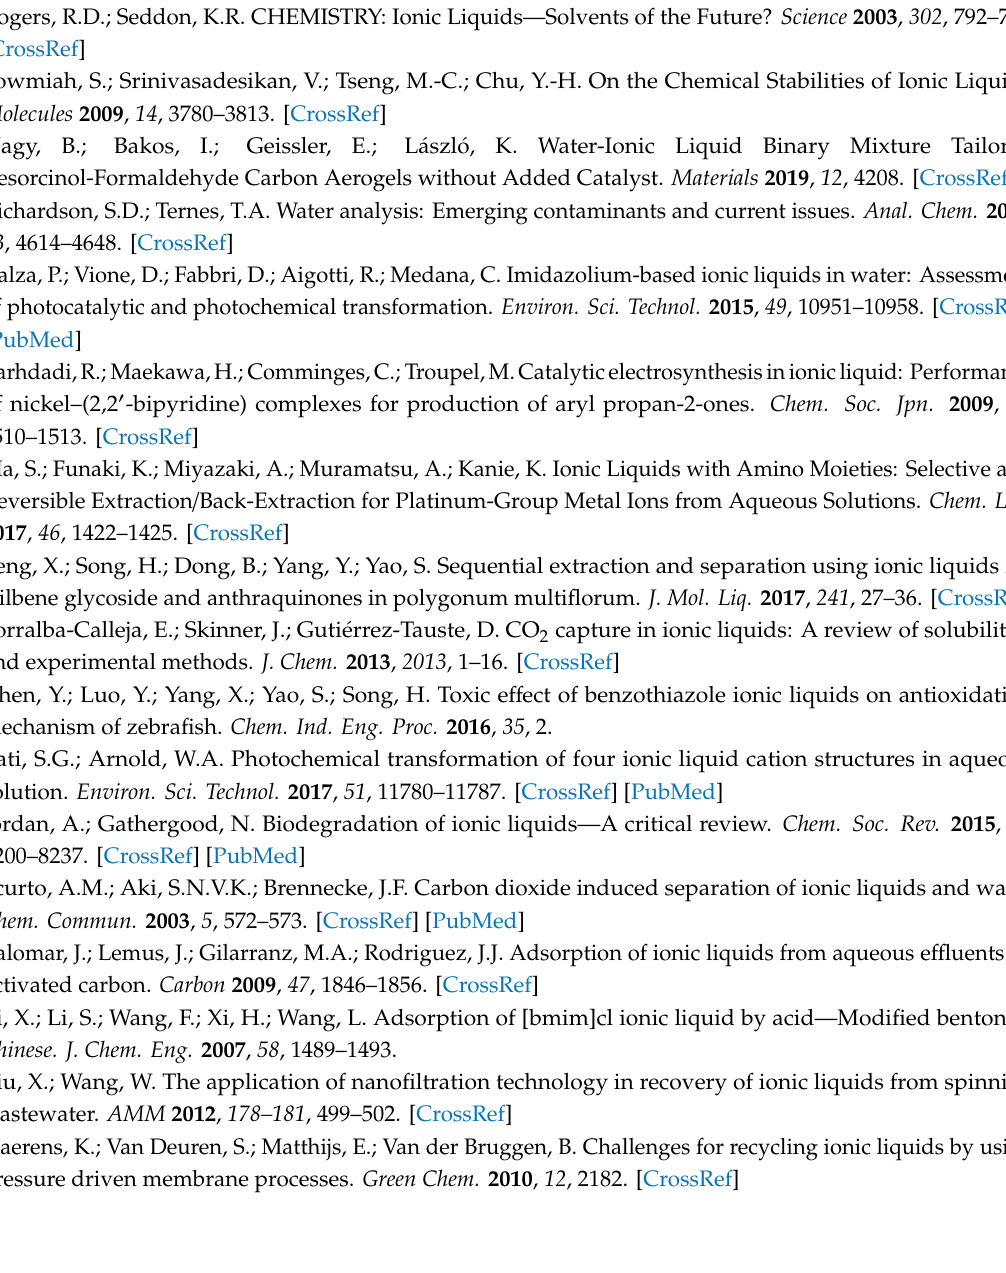
Figure S1. The synthesis procedure of benzothiazole-based ionic liquids; Figure S2. HPLC chromatogram of six benzothiazolium-based ionic liquids; Figure S3. E ff ect of concentration of ILs on degradation (a); E ff ect of concentration of ILs on kinetic constant (b); Degradation kinetic constants corresponding to di ff erent concentrations of ILs (c); Linear fit of lnk and lnc 0 (d); Table S1. Degradation rate constant k under di ff erent